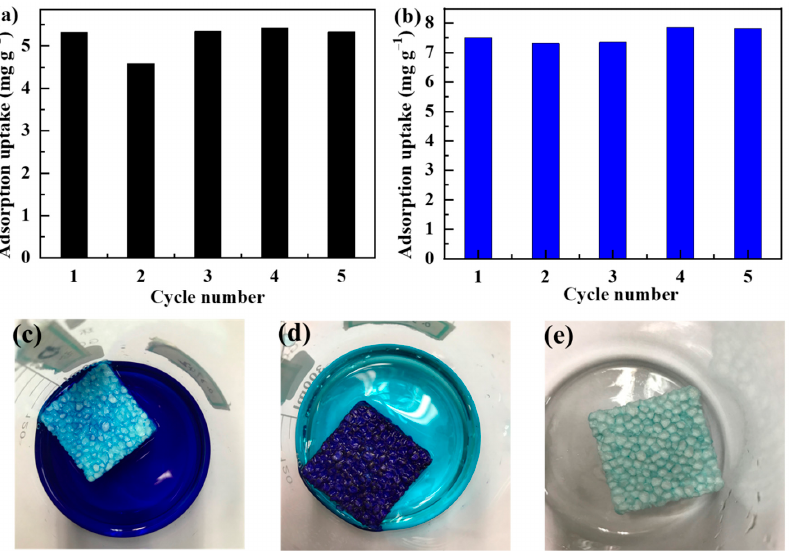
Figure 7. Cyclic adsorption of ( a ) Pb 2+ and ( b ) MB, and digital photos of SPS ( c ) before and ( d ) after adsorption of MB, and ( e ) after desorption. adsorption of MB, and ( e ) after